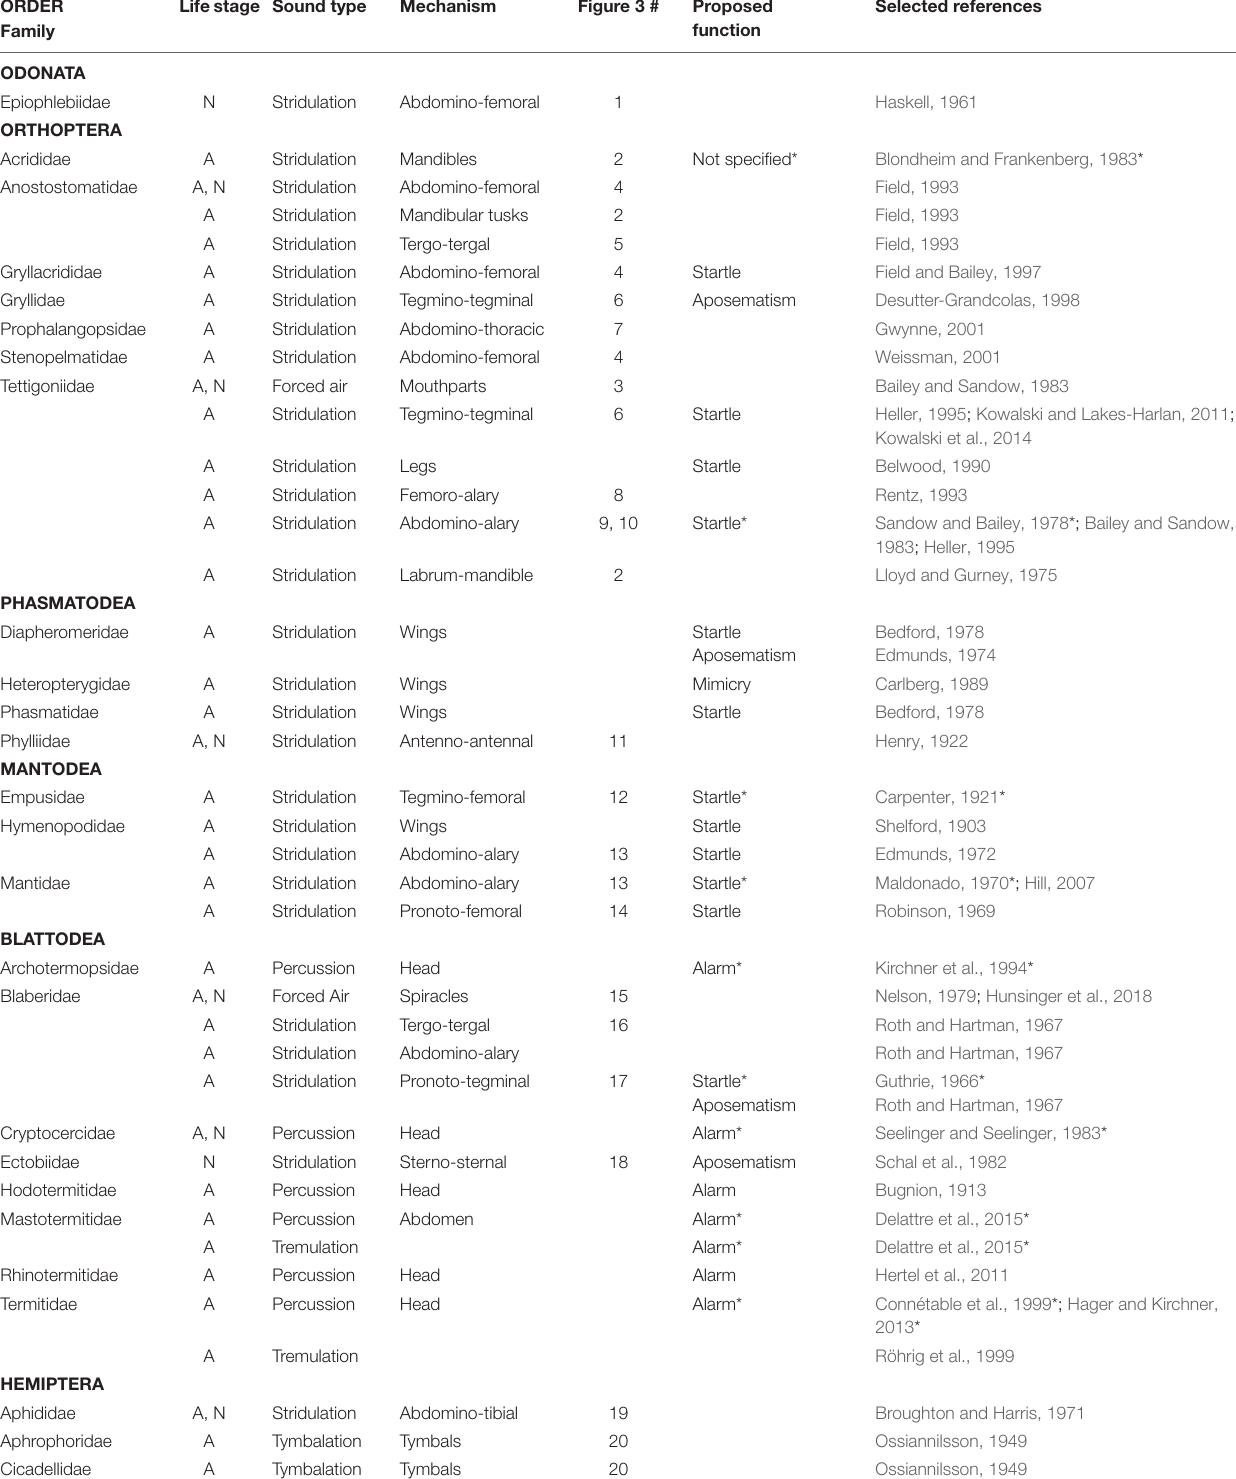
TABLE 1 | Distribution of insect defense sounds across orders, families, and developmental stages including information on mechanisms and proposed functions. A, adult; N, nymph; L, larva; P, pupa. “ Figure 3 #” refers to the corresponding label on Figure 3 . Asterisks denote cases where the sound was tested with a predator/receiver in the selected reference.